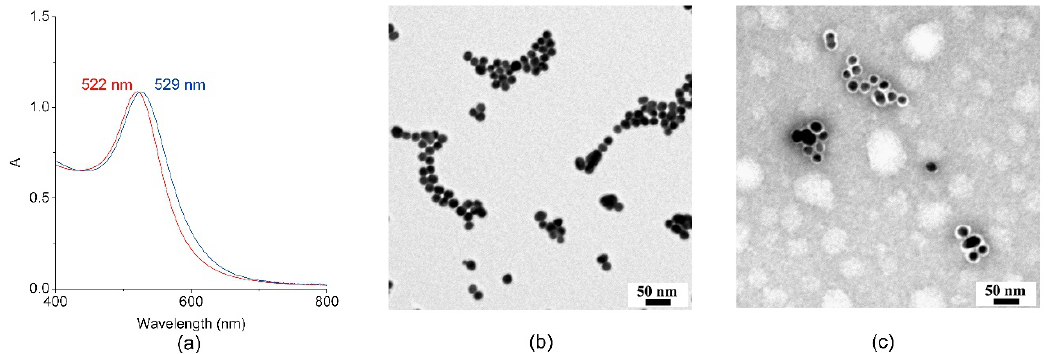
Figure 3. Characterization of MIMO@LA@AuNPs. ( a ) Visible spectra of citrate-capped AuNPs (red line) and of the bioconjugate MIMO@LA@AuNPs (blue line). ( b ) Transmission Electron Microscopy (TEM) image of citrate-capped AuNPs. ( c ) TEM image of the bioconjugate MIMO@LA@AuNPs. The staining with 1% uranyl acetate allowed highlighting the protein shell as a white halo around each AuNP.